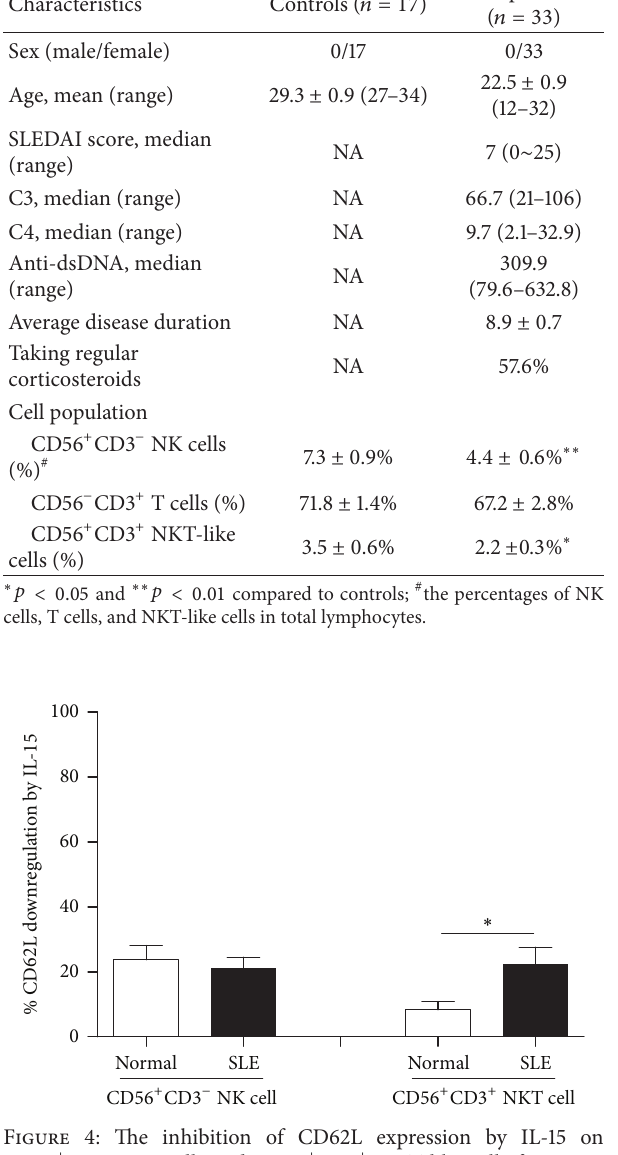
Table 1: Characteristics of controls and patients with SLE. Characteristics